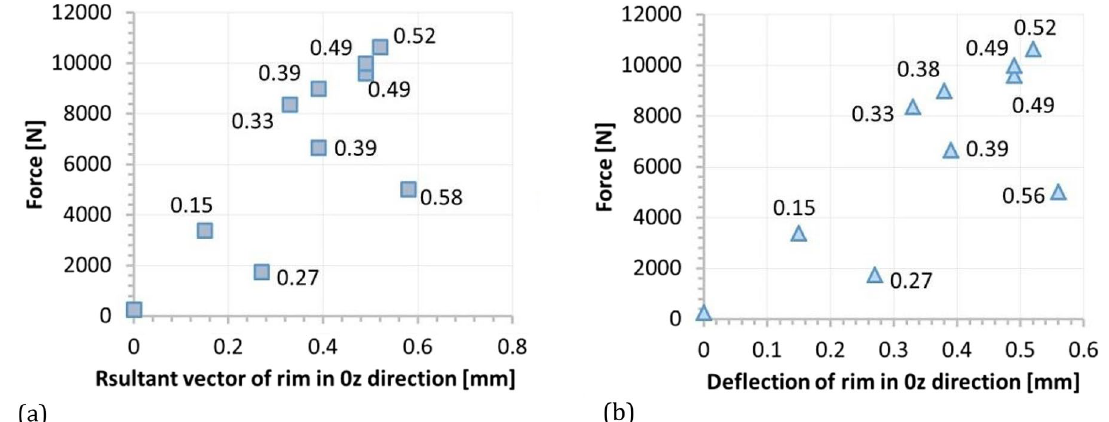
Figure 11. Force versus: ( a ) resultant vector of deflection, ( b ) deflection of tire in the 0z direction for rim.